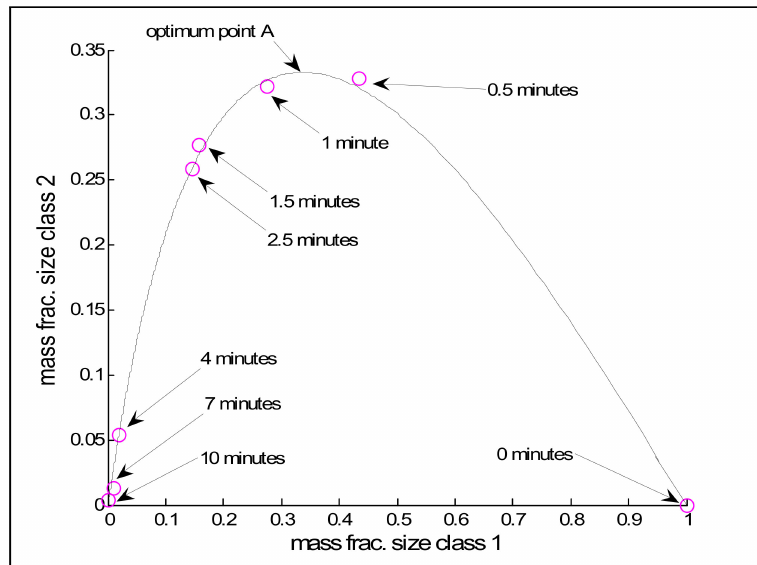
Figure 4. Representation of particle size distributions as a single trajectory in the AR space [7].